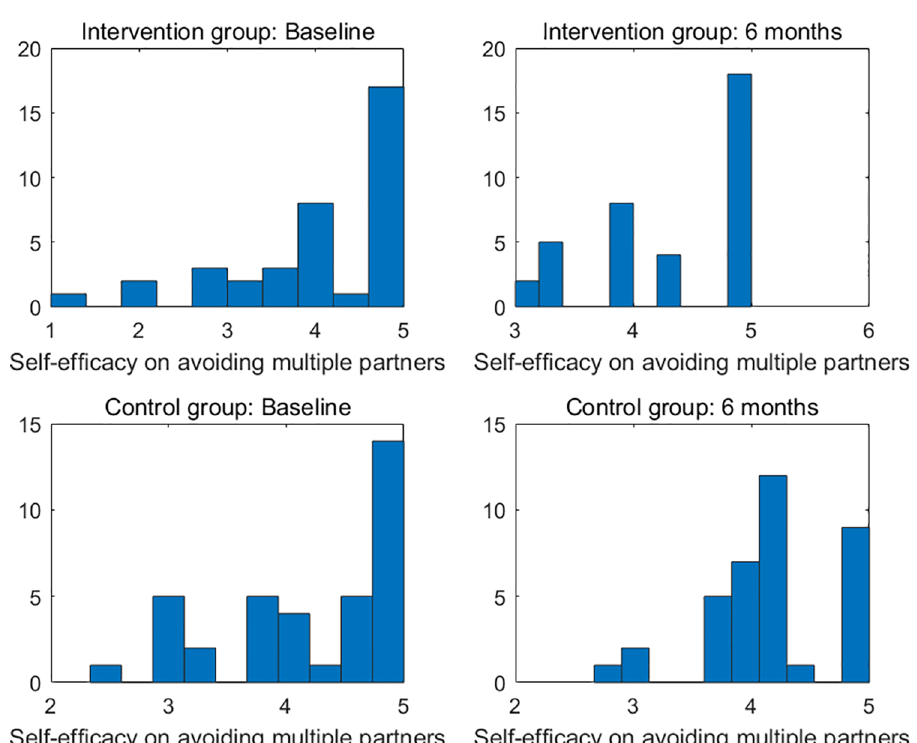
Fig 2. Histograms of self-efficacy on avoiding multiple partners for treatment and control groups at baseline and 6-month visits.